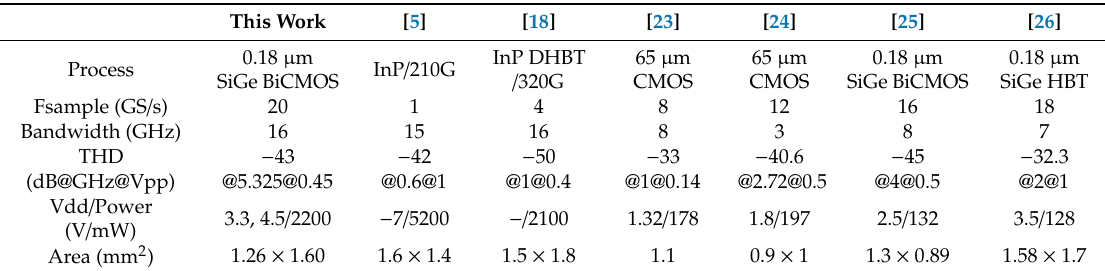
Table 2. Performance summary and